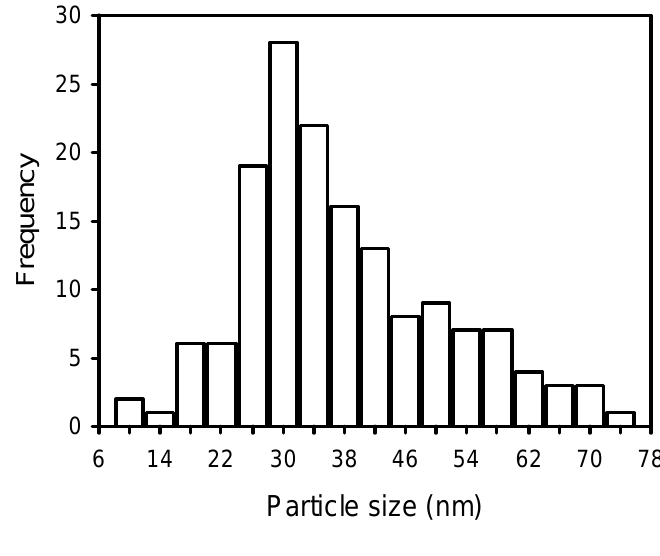
Figure 4 . Particle size distribution extracted from STM